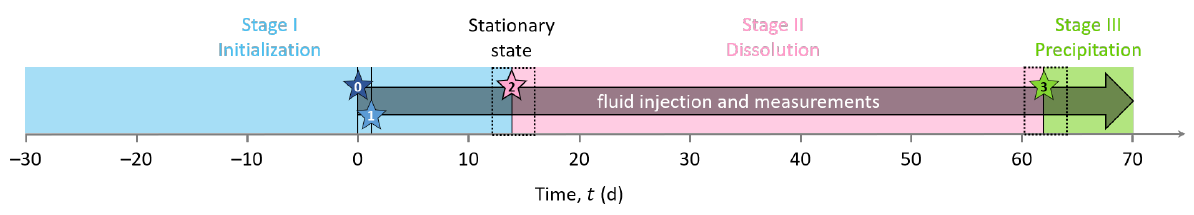
Figure 3. Timeline of the experiment successive stages and events. Blue, pink, and green rectangles indicate the different stages: Stage I consists of the initialization to reach a stationary state close to equilibrium with calcite; Stage II corresponds to calcite dissolution with the constant injection of hydrochloric acid (solution S1); Stage III refers to calcite precipitation with the constant injection of a calcite over-saturated solution (S2). The four stars of the timeline are related to specific events. Event 0 refers to the turning on of the peristaltic pump. Event 1 refers to the connection between the inlet and outlet for recirculation of the solution in the sample. Event 2 refers to the disconnection between the inlet and outlet compartments and to the start of injecting solution S1. Event 3 refers to the start of injection of solution